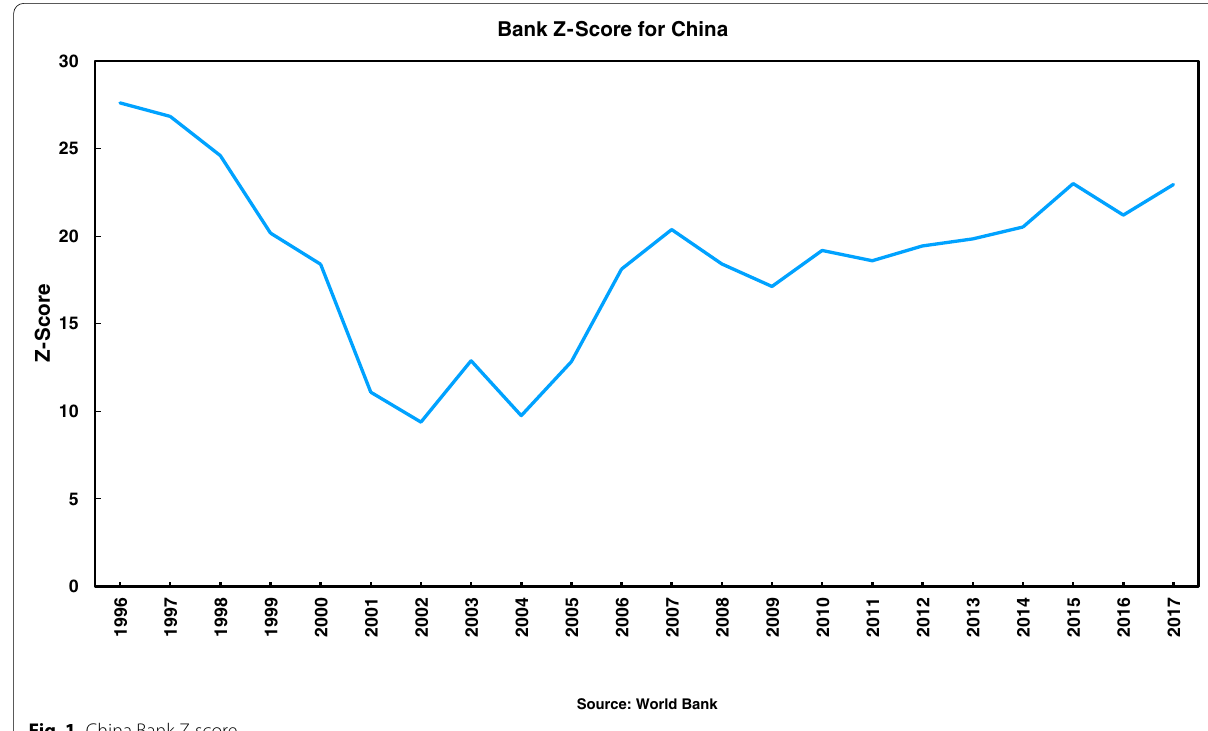
Fig. 1 China Bank Z-score